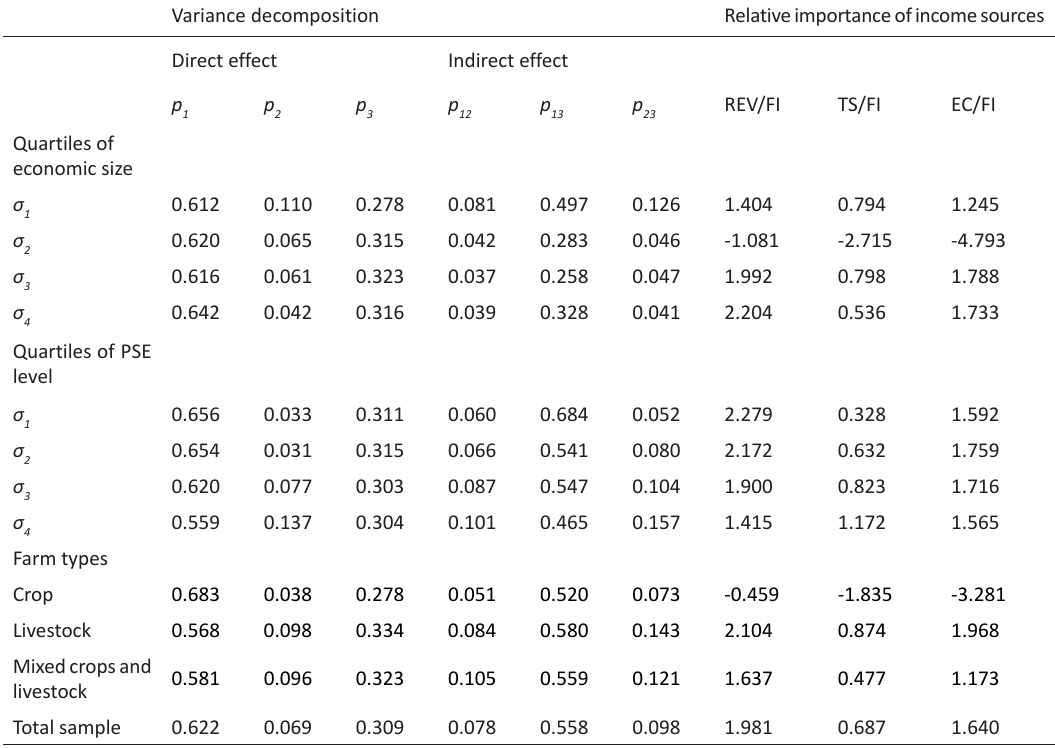
Table 3. Results of variance decomposed of FI (full sample including observations with negative